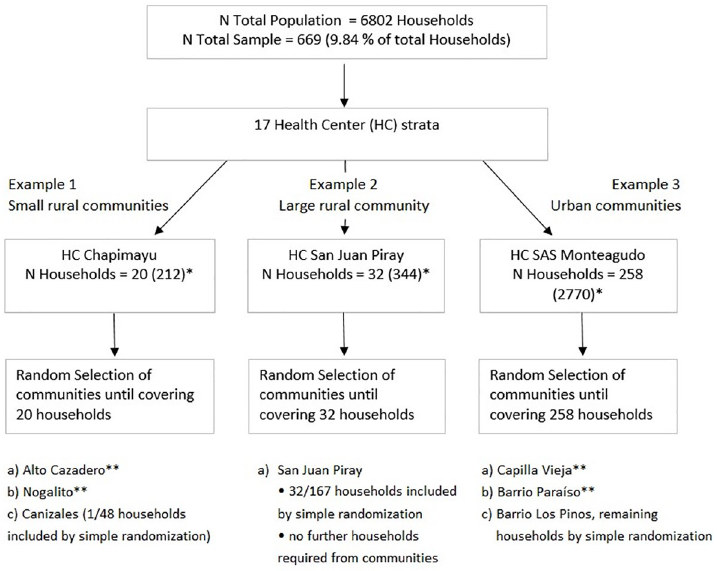
Fig 2. Flow chart of multistage stratified random sampling with examples for different settings encountered. � The existing number of households, especially in small communities, was often lower than provided by the official census NCP data, as these also contain abandoned households. Small variations in sampling were partly due to logistic reasons. �� All encountered households were included.